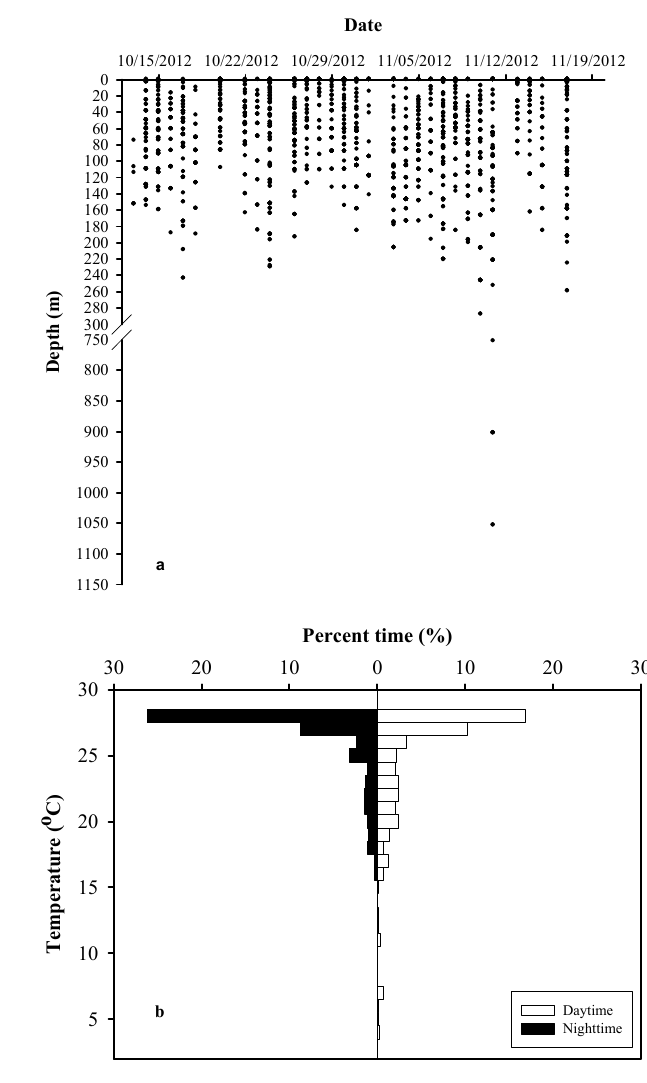
Fig. 8. Vertical movement distribution (a), and percentage of time spent at different temperature (b) for the fi sh bearing tag